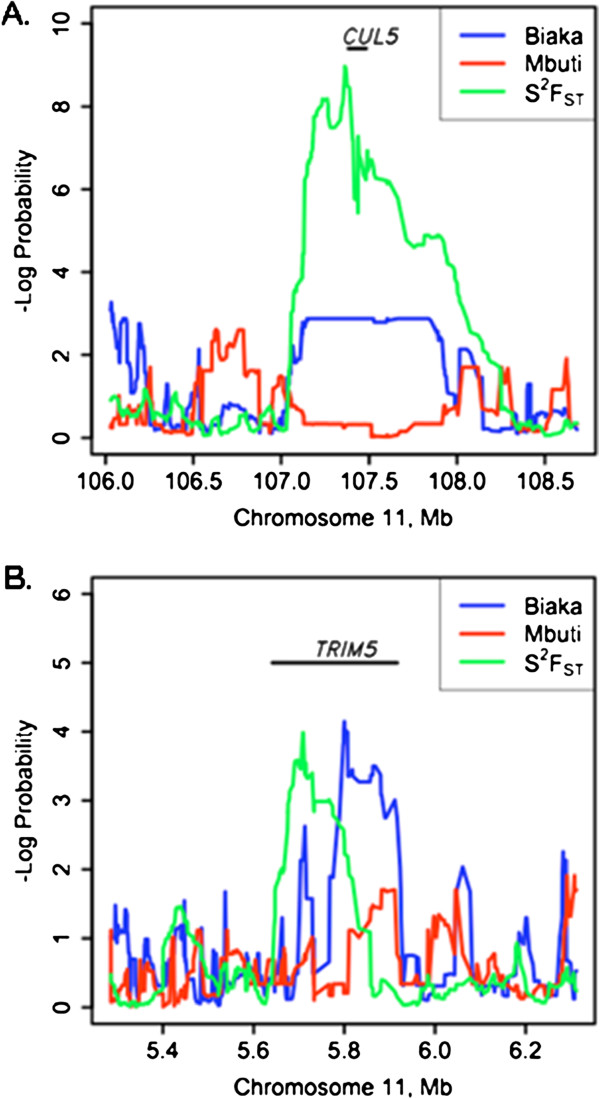
Signature plots for two host genes associated with HIV-1, under potential recent selection in the Biaka when compared to the Mbuti. The x-axes show chromosomal positions for CUL5 (panel A) and TRIM5 (panel B). The y-axes map λ scores across moving windows of SNPs, used to examine the genome for signatures of selection [19]. Note that the x- and y-axes for the two genes use different scales. The lines represent values calculated for heterozygosity in Biaka (blue) and Mbuti (red) within populations (low heterozygosity when lines are at high values), and for the variance of FST between populations (green; high variance of FST when lines are at high values). Signatures of “new” or recent selection for CUL5 and TRIM5 in the Biaka are indicated by the overlapping peaks for Biaka heterozygosity and for variance of FST[19]. The positions of the genes are indicated in the plots.